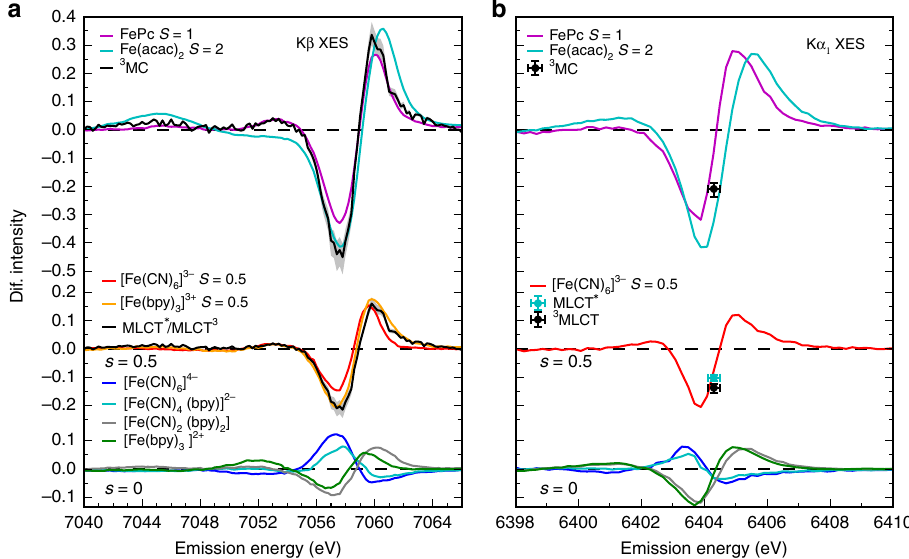
Fig. 2 Fe K α /K β XES electronic state and ligand dependence. a K β and b K α XES difference spectra ( S — nominal spin of the Fe center; bpy = 2,2 ′ - bipyridine, Pc = phtalocyanine, acac = acetylacetone). (Lower level) XES difference spectra of model S = 0 complexes with various ligands (blue, cyan, gray and green lines). (Middle level) K β XES difference spectra (black lines) and K α difference intensities (black/cyan dots) of MLCT ( S = 0.5) excited states as retrieved from the XES population kinetics fi tting described in the main text, compared with the S = 0.5 model spectra (red and orange lines). (Upper level) Similar comparison for the 3 MC ( S = 1) [Fe(bmip) 2 ] 2 + spectra/intensities and the S = 1 (magenta lines) and S = 2 (cyan lines) model spectra. Shaded areas ( a ) and error bars ( b ) correspond to the fi ts with excitation yield within the range of 74 – 94%. Difference spectra are calculated by subtracting the ground state spectrum of [Fe(bmip) 2 ] 2 + ( S = 0). Complete model spectra are included in the Supplementary Note